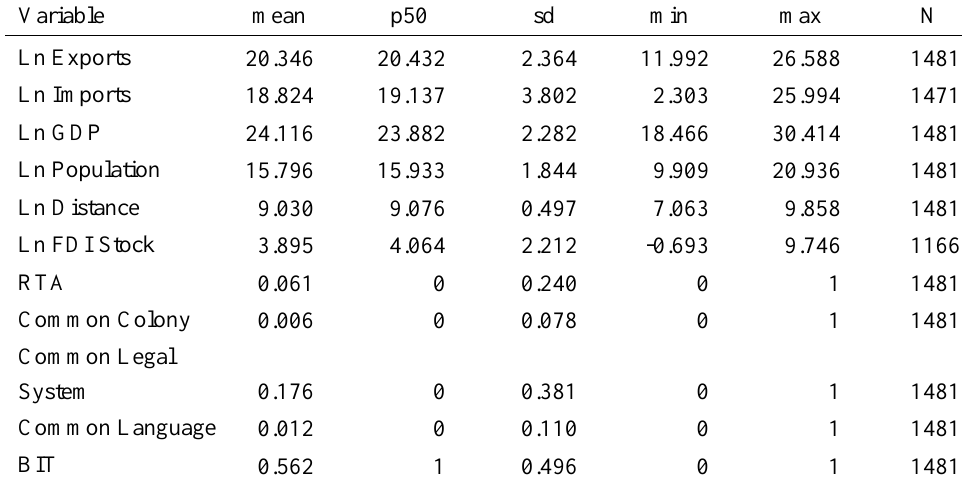
Table 1 . Summary Statistics